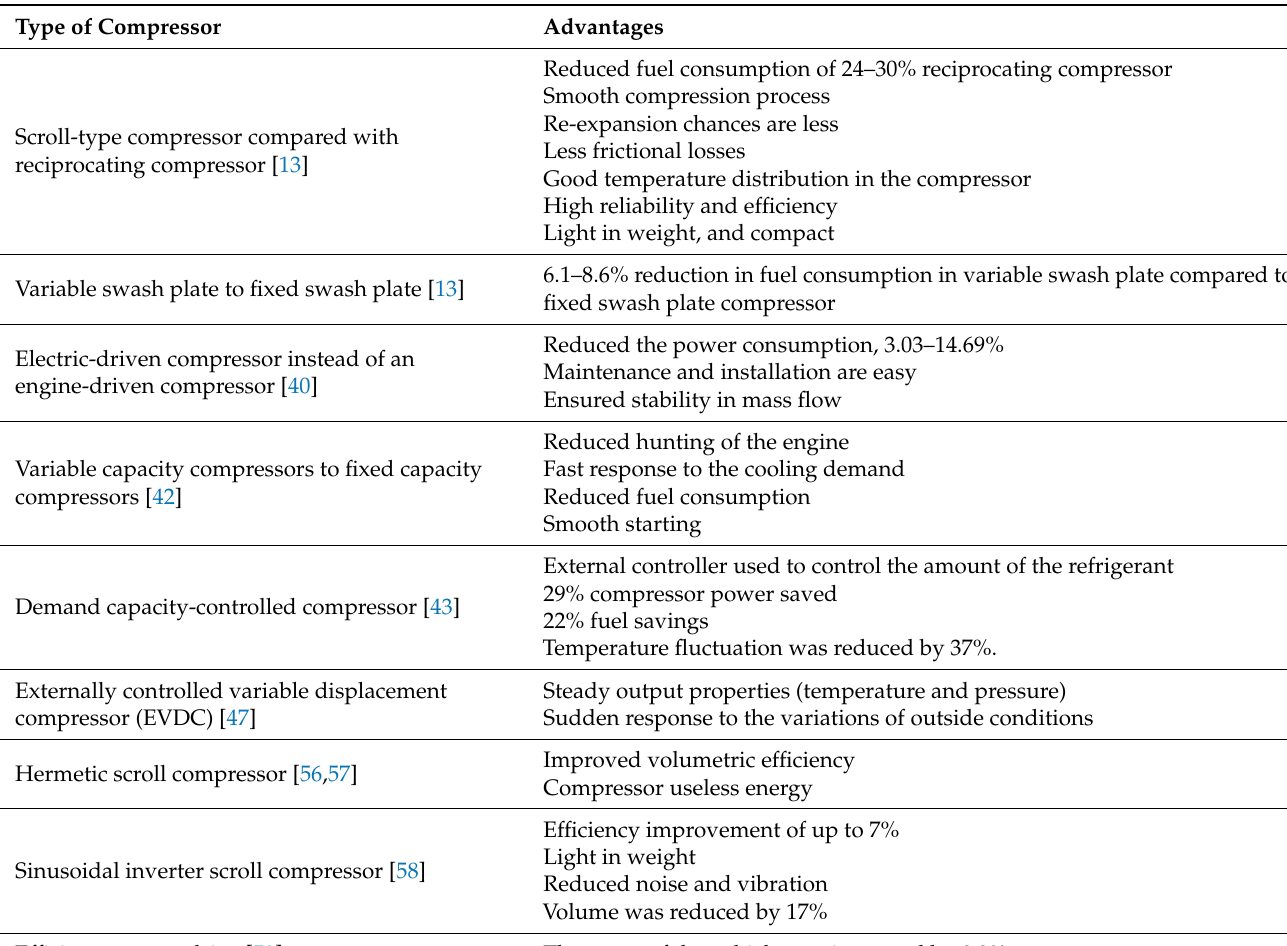
Table 4. Type of compressors and its